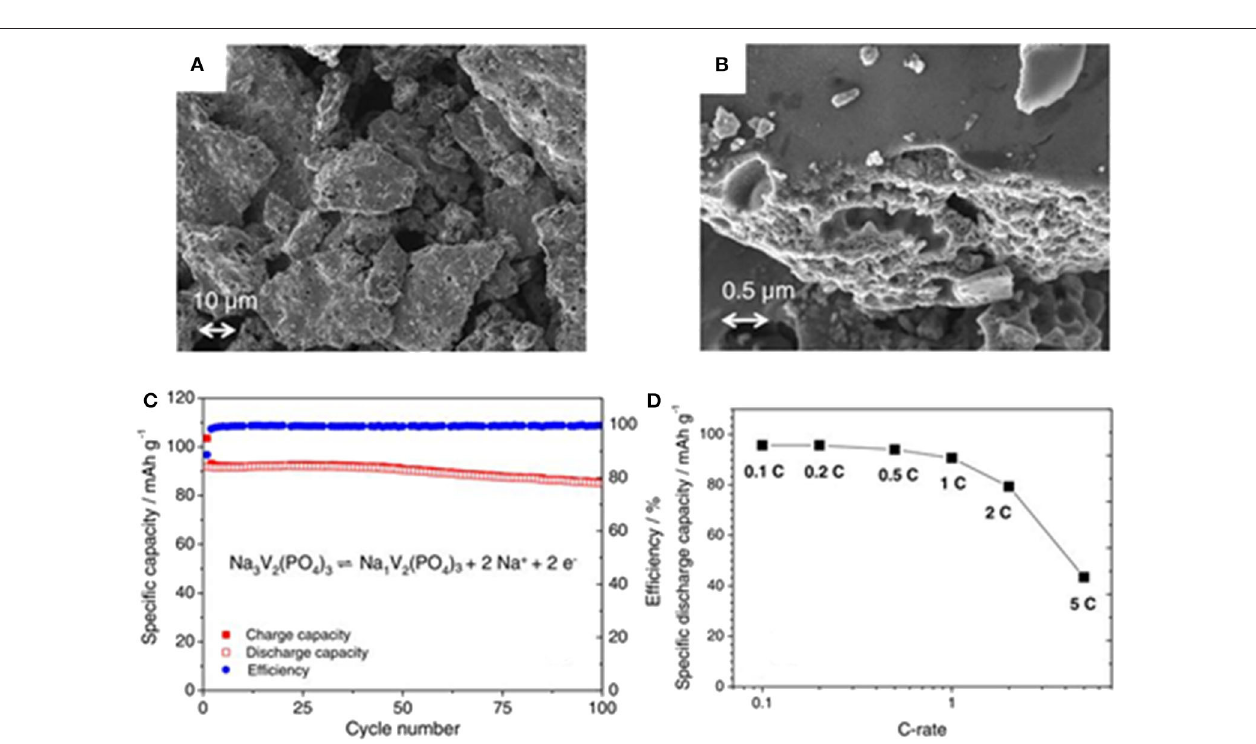
FIGURE 3 | (A,B) The SEM images of NVP/C, (C) constant-current charge/discharge of NVP-based electrodes material at 1C, (D) C-rate test of Na 3 V 2 (PO 4 ) 3 -based